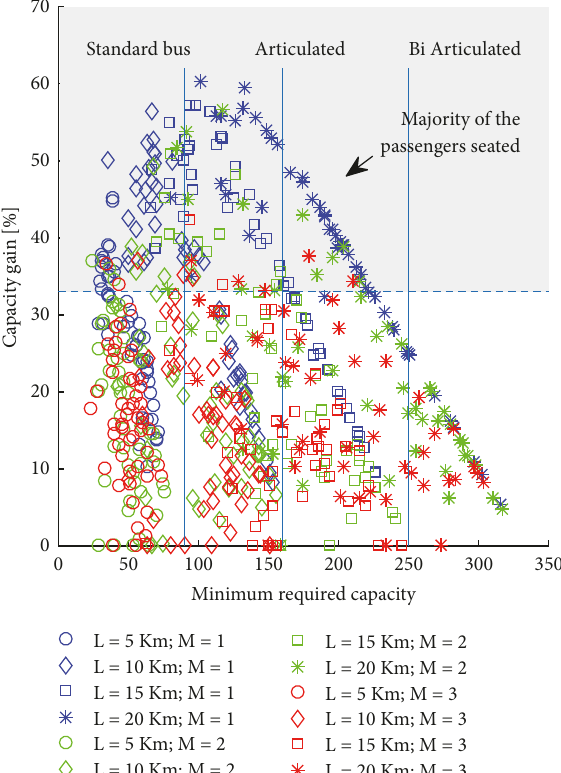
Figure 5: Scatter diagram of the minimum required capacity and the capacity gain.